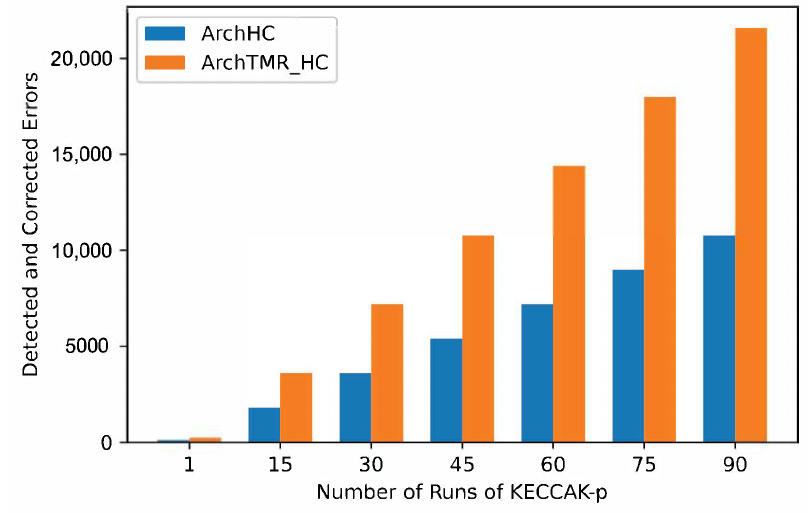
Figure 11. Error coverage